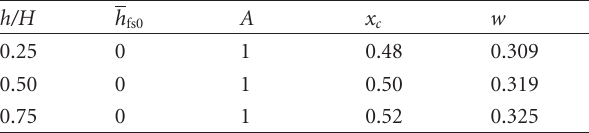
Table 1: Parameters for fitted curves of the free